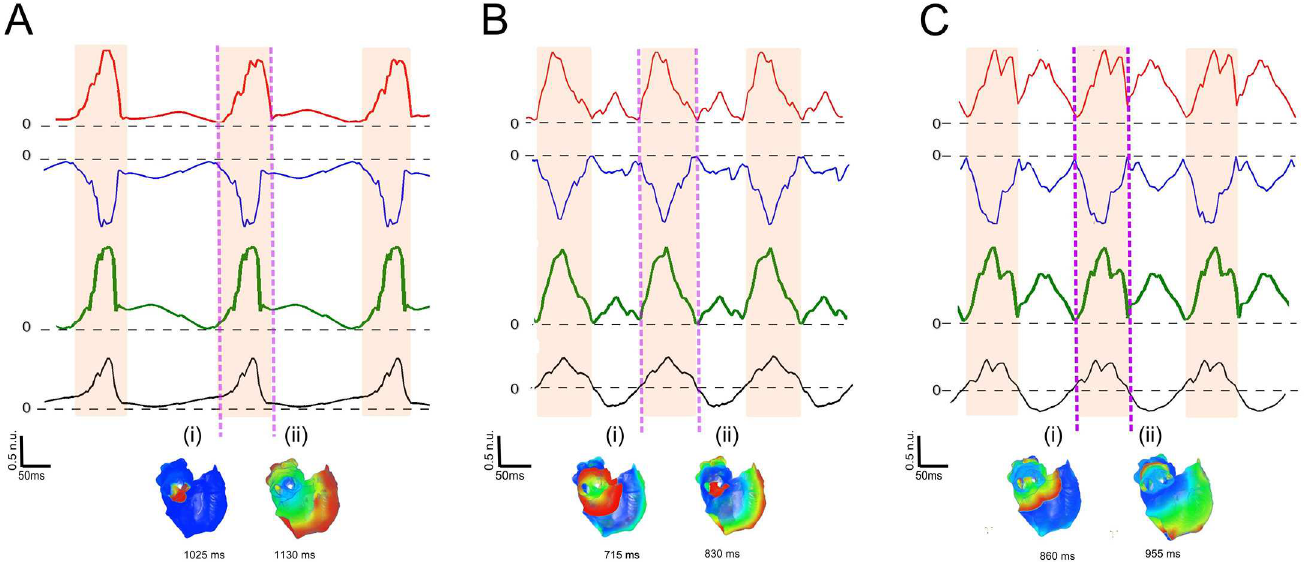
Fig 3. Dipole and atrial activation evolution in different atrial activations located in the pulmonary veins (PV). (A) Slow ectopic atrial activation focus in the PV (non fibrillatorywaves observed). (B) Fast focal activationfocus in the PV (F-waves observed). (C) Re-entrant activationaroundthe PV (F-waves observed). Red line: Positive dipole. Blue line: Negativedipole. Green line: Dipolesum. Black line: lead V1 (ECG). The Magentaregions represent the time interval of the main atrial wave, selectedfrom the peaks in the dipolepattern. (i)-(ii) Snapshots of the atria activationat the beginning and end of the time interval